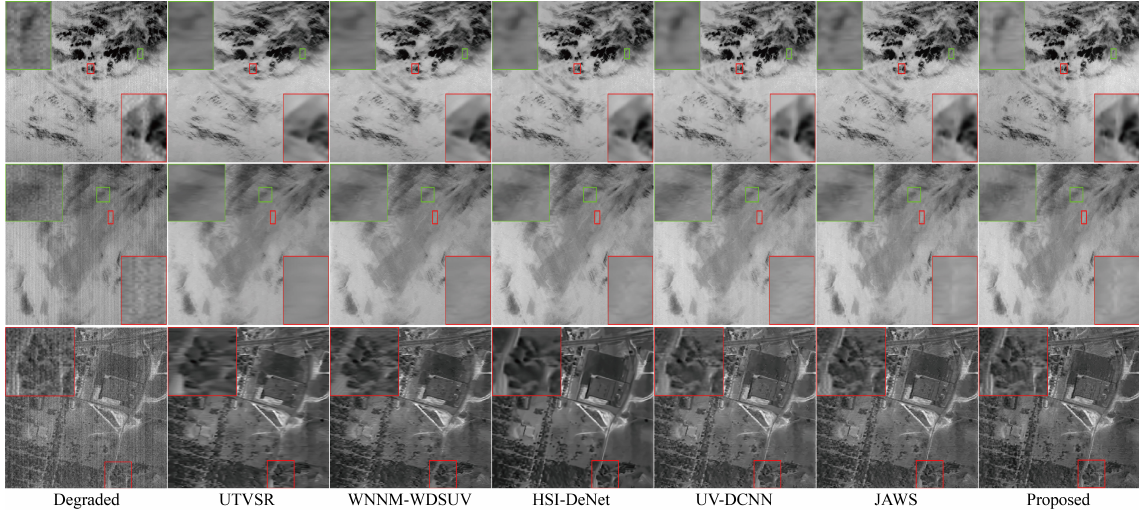
Figure 13. Visual comparisons of the estimated results on the real-world degraded RAM1 , RTM1 , and Hyperspectral urban images in Figure